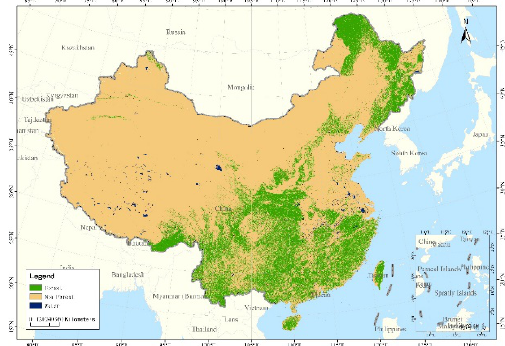
Figure 4. The forest extraction result in China